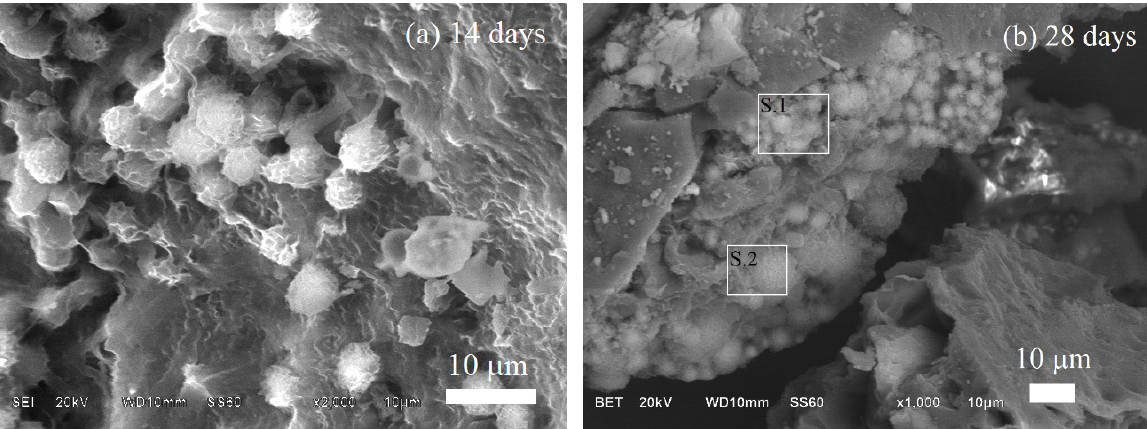
Figure 12. Scaffold SEM analysis for BG30-PLA70 after ( a ) 14 days and ( b ) 28 days of immersion in PBS. Table 6. EDS chemical analysis for BG-PLA composites after immersion in PBS.